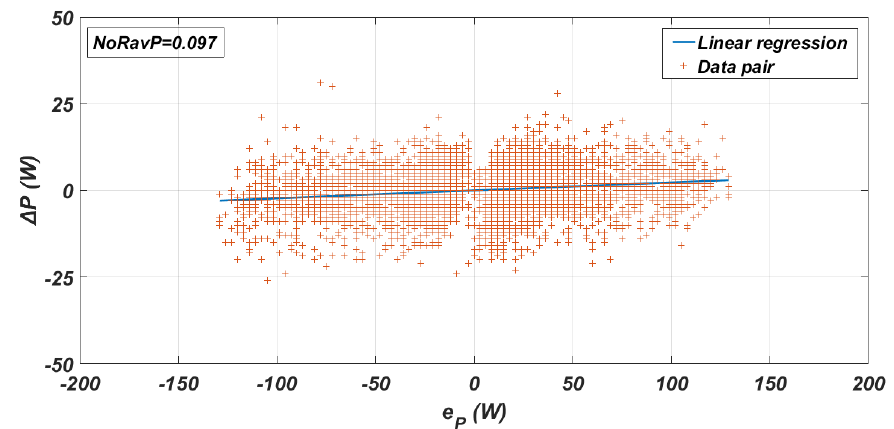
Figure 4. Plot and linear regression of [ e P ( t ), ΔP ( t )] pairs used for the calculation of NoRavP for the properly configured Power Transformation Matrix with Virtual Resistor (PTMVR) control method.